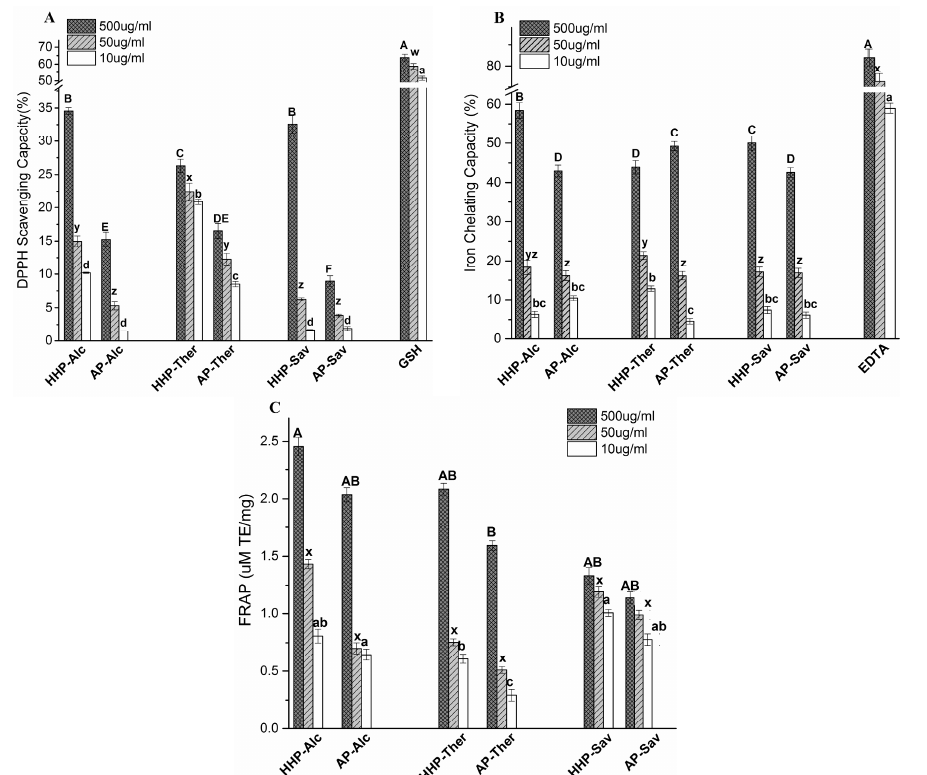
Figure 3. The antioxidant capacity of selected β -lactoglobulin hydrolysates produced under HHP and AP condition. ( A ) DPPH scavenging capacity; ( B ) iron chelation capacity and ( C ) ferric reducing antioxidant power (FRAP) values of β -lactoglobulin hydrolysates produced by Alcalase (Alc), Thermolysin (Ther), and Savinase (Sav). The statistical analysis of the results was performed by two-way ANOVA followed by a Duncan multiple comparisons test. The bars and error bars represent means and standard errors, respectively ( n ≥ 3). For each concentration level, means with different lowercase letters differ significantly ( p < 0.05).